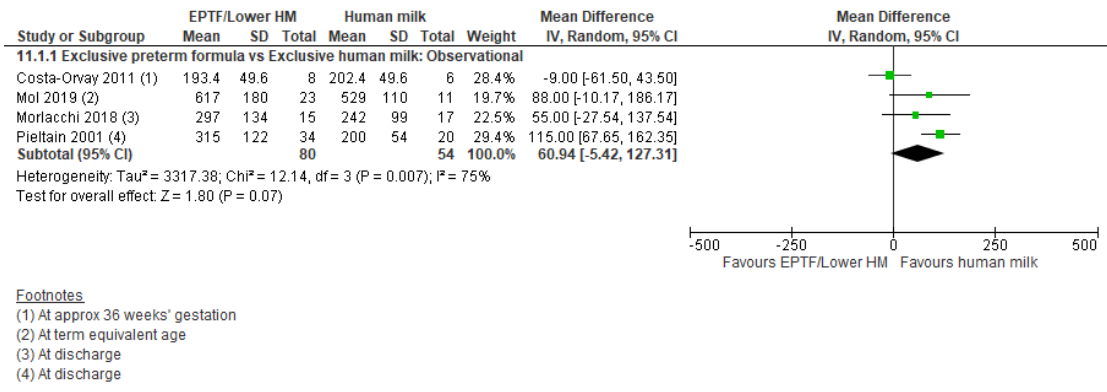
Figure 10. Forest plot of mean difference in change in % fat mass and human milk intake.